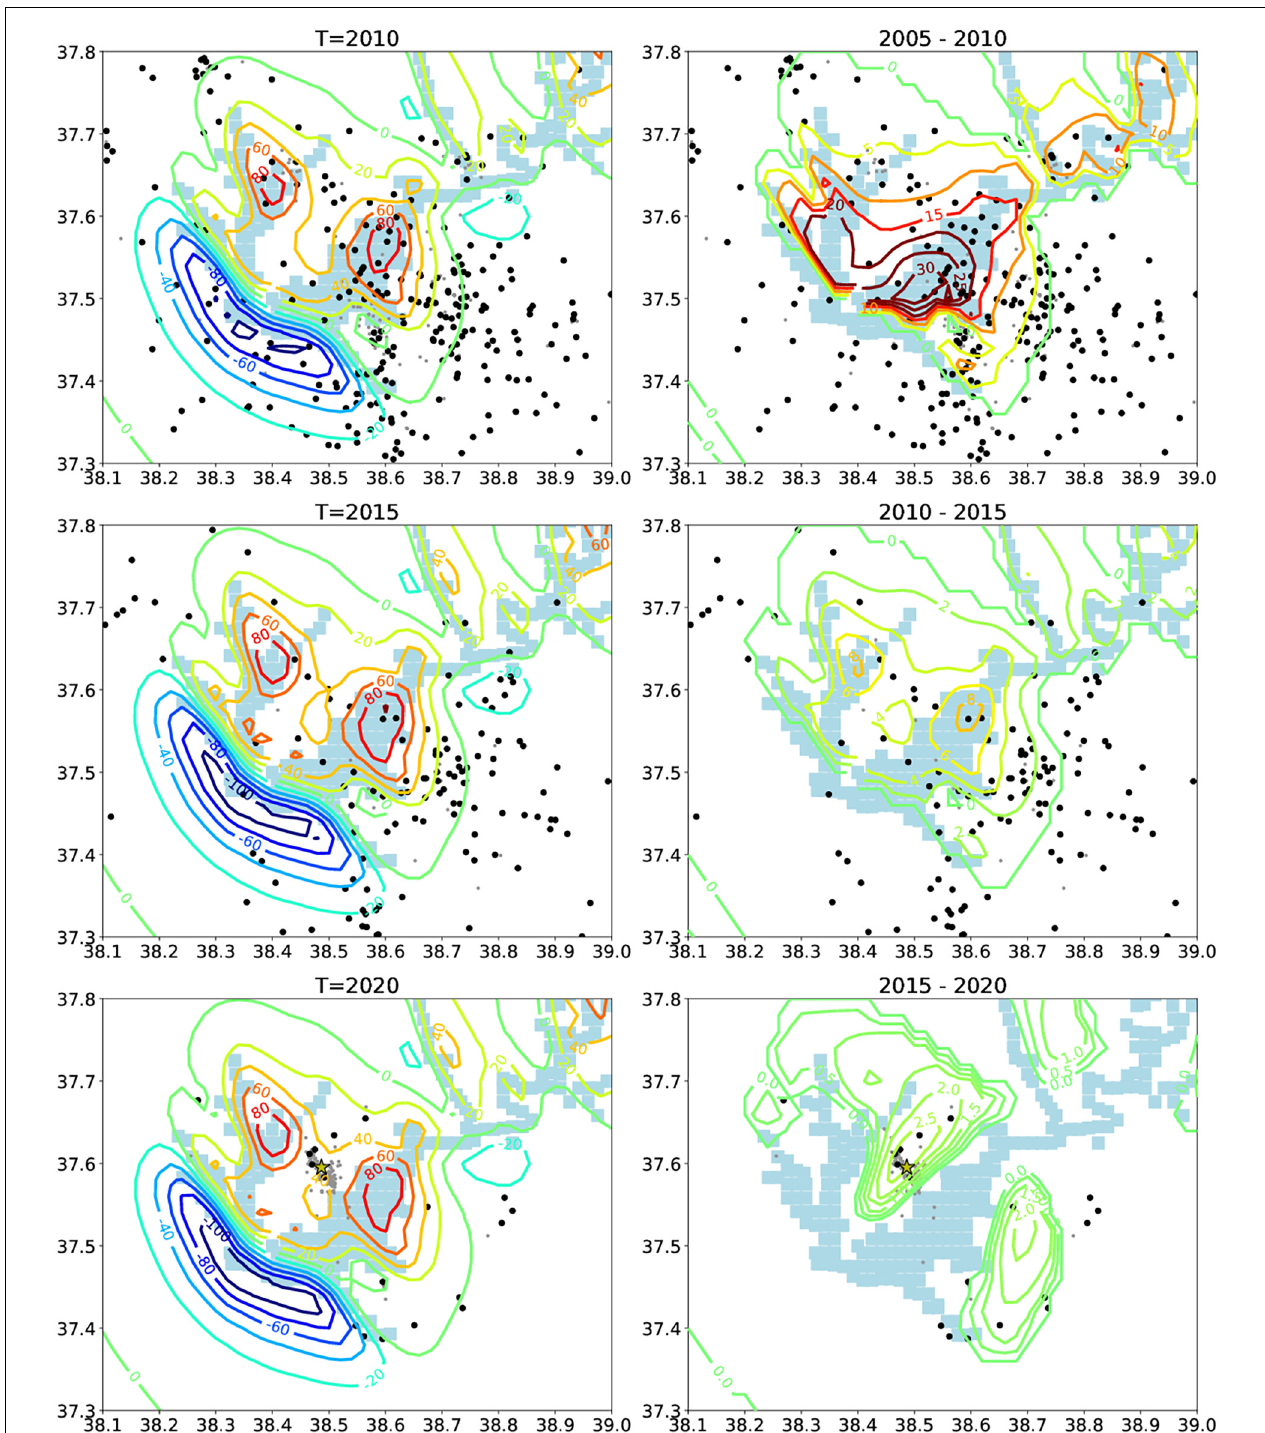
FIGURE 11 | Left column : contour lines of the total CFS-stress [kPa] at the year 2010 (top) , 2015 (middle) , and 2020 (bottom) , calculated for the mainshock mechanism at a depth of 5 km and D = 0.1 m 2 /s. Right column : increase of the maximum CFS value in the period 2005–2010 (top) , 2010–2015 (middle) , and 2015–2020 (bottom) , which is proportional to the number of triggered earthquakes according to the simple CFS-model. For comparison, the epicenters of earthquakes (M ≥ 2.8, black = declustered, gray = aftershocks) recorded in the corresponding time intervals are plotted. In the bottom row, the star refers to the 2017 M w 5.5